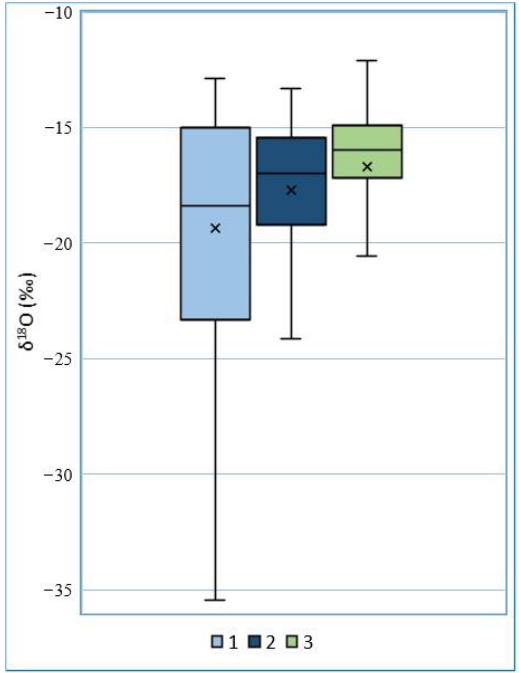
Figure 3. Box plots for δ 18 O in valley glaciers ice in the Tavan-Bogd (1), Mongun-Taiga (2) and Tsambagarav (3) massifs. Table 2. Mean δ 18 O values for valley glaciers in 3 research areas. Massif